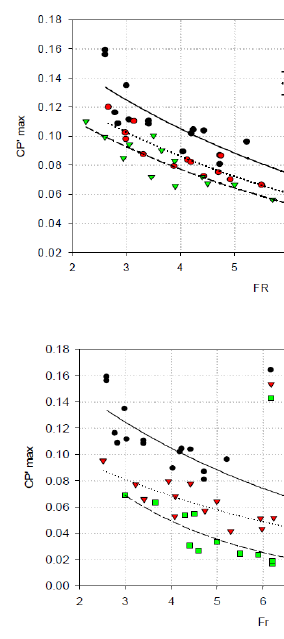
Figure 9. The values of C P (cid:48) max in different expansion ratios. Table 2. Comparison of reduction percentage of C P (cid:48) max in respect to smooth prismatic jump. Type of Jump Reduction (%) of C P (cid:48) max smooth bed and sudden expansion; β = 0.67 18 smooth bed and sudden expansion; β = 0.5 23 smooth bed and sudden expansion; β = 0.33 30 rough bed and prismatic jump; β = 1 20 rough bed and sudden expansion; β = 0.67 27 rough bed and sudden expansion; β =